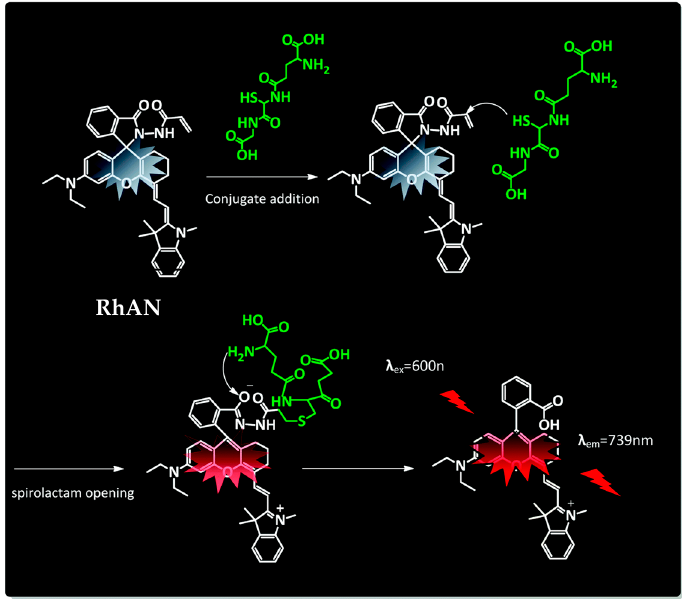
Figure 15. The possible mechanism of RhAN sensing toward GSH based on conjugate addition and intramolecular amino induced spirolactam opening. Adapted with permission from [225].